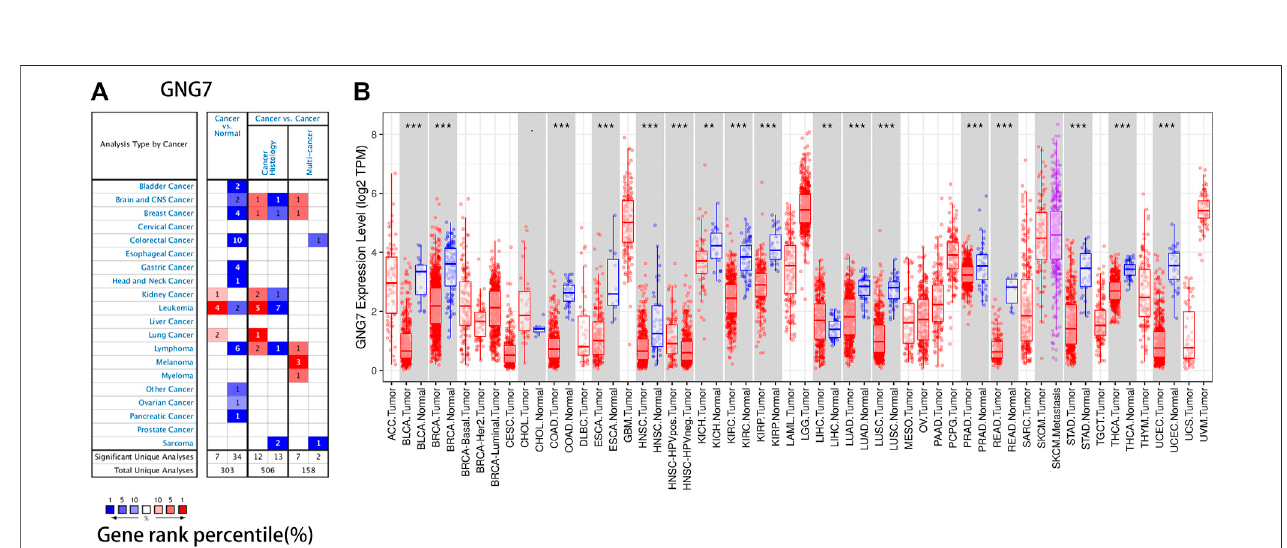
FIGURE 3 | GNG7 mRNA expression in a variety of human cancers. (A) GNG7 expression was downregulated or upregulated in diverse cancers in the Oncomine database. (B) Human GNG7 expression in multiple types of cancer was determined using the TIMER database (* p < 0.05, ** p < 0.01, *** p < 0.001).